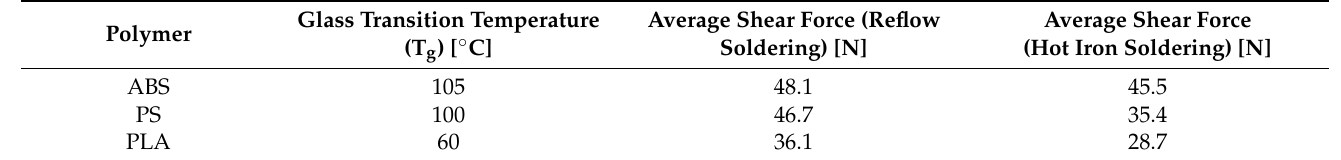
Table 5. Glass transition temperature for different polymers according to literature.